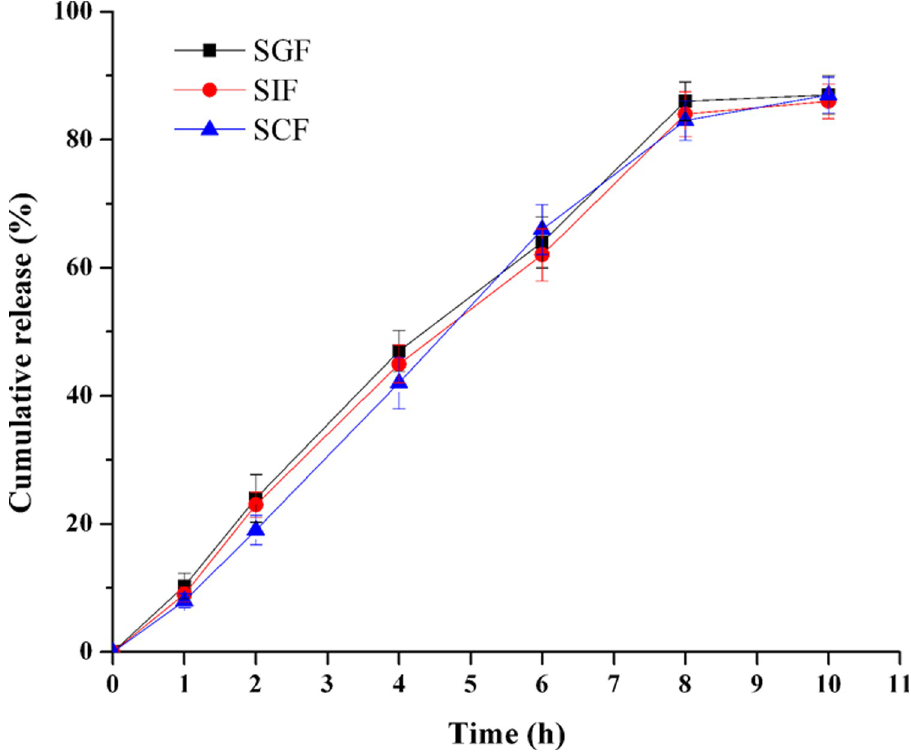
Fig 14. Effect of release media on TPM release in optimal formulation (n = 6). SGF: simulated gastric fluid; SIF: simulated intestinal fluid; SCF: simulated colonic